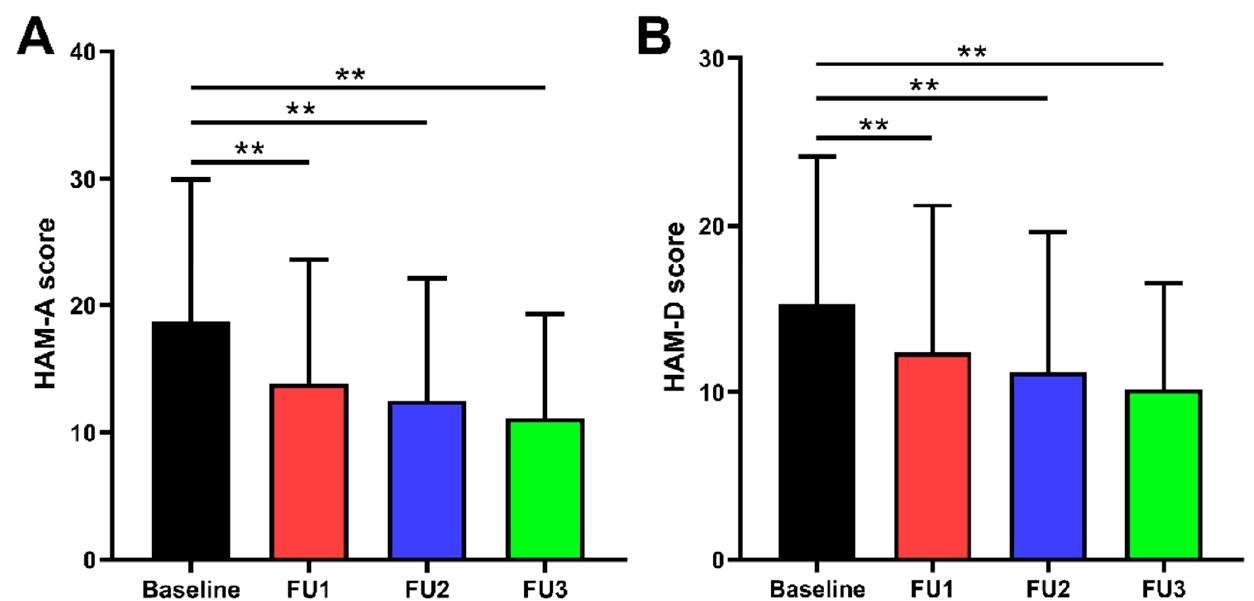
Figure 1. Comparison of preoperative and postoperative HAM-A and HAM-D scores: ( A ) HAM-A scores were improved by 23.5% (IQR 34.9%), 33.3% (IQR 30.9%), and 41.7% (IQR 34.9%) at 1, 3, and 6 months follow-up, respectively. ( B ) HAM-D scores were improved by 20.0% (IQR 33.3%), 31.0% (IQR 32.7%), and 37.5% (IQR 33.4%) at 1, 3, and 6 months follow-up, respectively. ** p < 0.001; Base- line = preoperative; FU1 = follow-up 1 month after surgery; FU2 = follow-up 3 months after surgery; FU3 = follow-up 6 months after surgery.